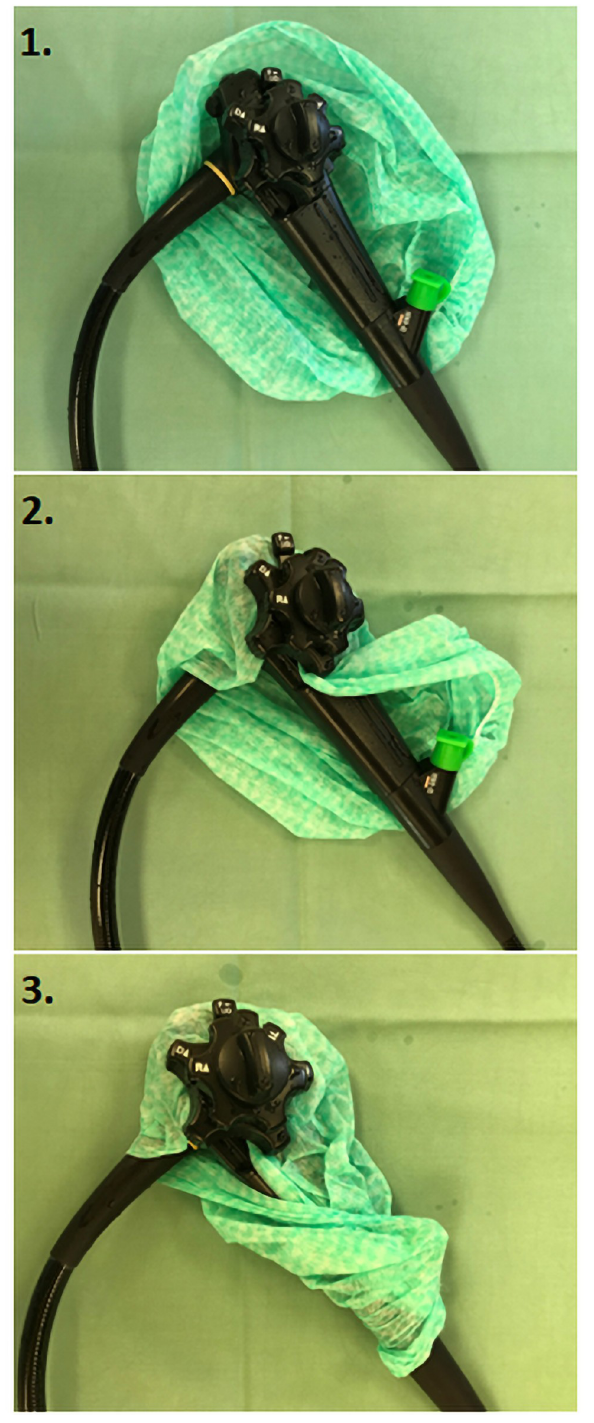
Fig 6. Instructions on how to create a protective cover. The picture shows instructions on how to create a protective cover for the endoscope control body in three steps.